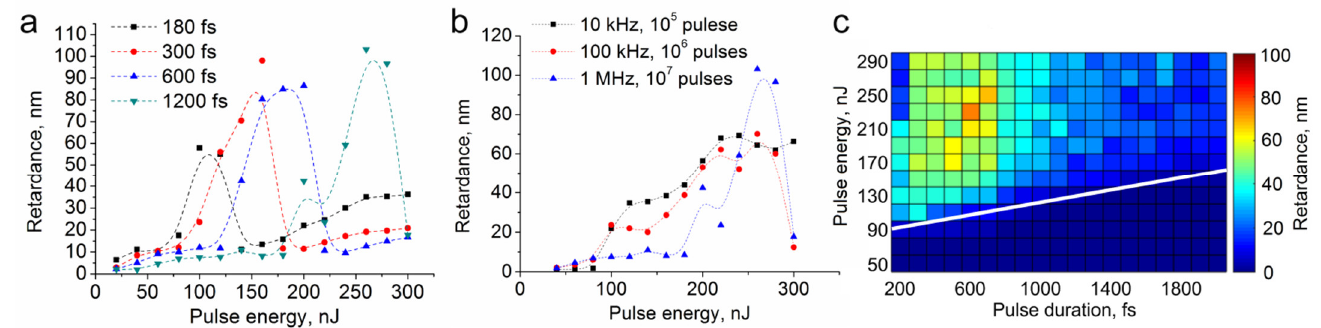
Figure 2. ( a ) Dependence of retardance on the pulse energy in the dots written at 1 MHz repetition rate; ( b ) Dependence of retardance on pulse energy in the dots written at 600 fs pulse duration; ( c ) Dependence of retardance on the pulse energy and pulse duration in the tracks written at 10 kHz repetition rate and 3 μm/s scanning speed.